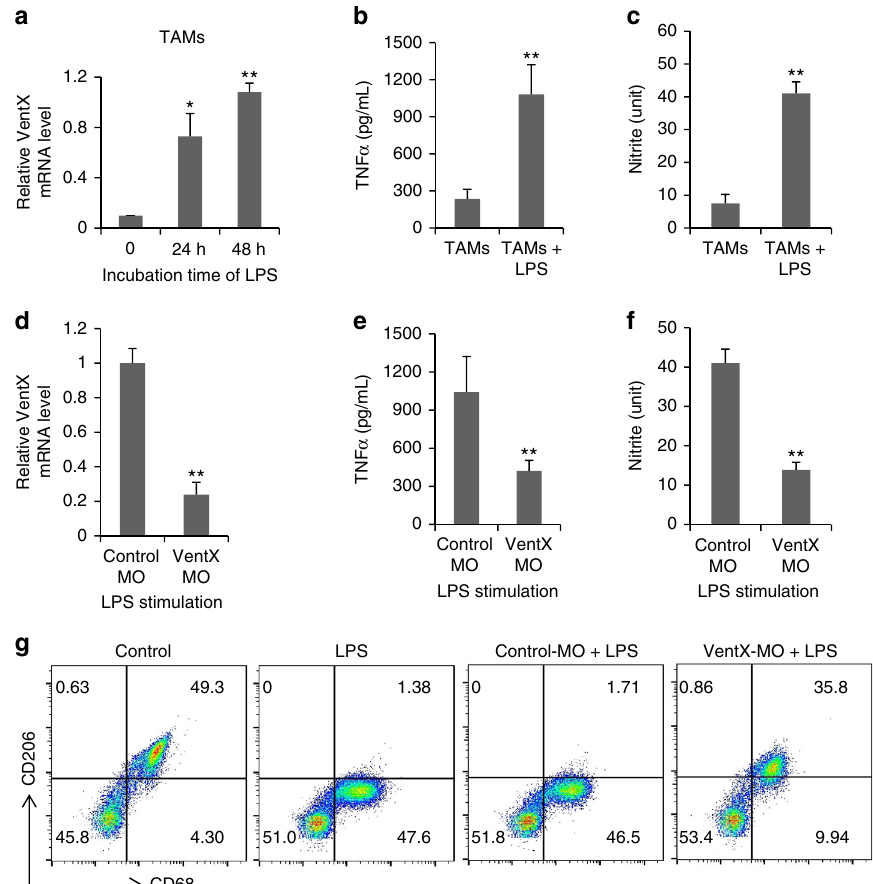
Fig. 2 VentX regulates TAM plasticity. a VentX expression in TAMs after LPS stimulation. Isolated TAMs were cultured in RPMI medium and stimulated with LPS. VentX mRNA levels were measured with real-time PCR at indicated times. b TNF- α and c nitrate level from TAMs after LPS treatment were determined by ELISA and Griess reagent. d Effects of VentX-MO on VentX expression. Isolated TAMs were transfected with MO oligonucleotides targeting VentX or control. Twenty-four hours post transfection, LPS was added to culture medium. The cells were collected 48 h later and VentX expressions were determined by real-time RT-PCR. e TNF level and f nitrate level from VentX-MO- or control-MO-treated TAMs after LPS stimulation. Data shown are mean ± SD of three independent experiments and paired Student ’ s t -test was performed. * p < 0.05, ** p < 0.01. g Effects of VentX-MO or control-MO on percentage of CD206 + CD68 + TAMs after LPS stimulation. Representative data of at least three independent experiments were